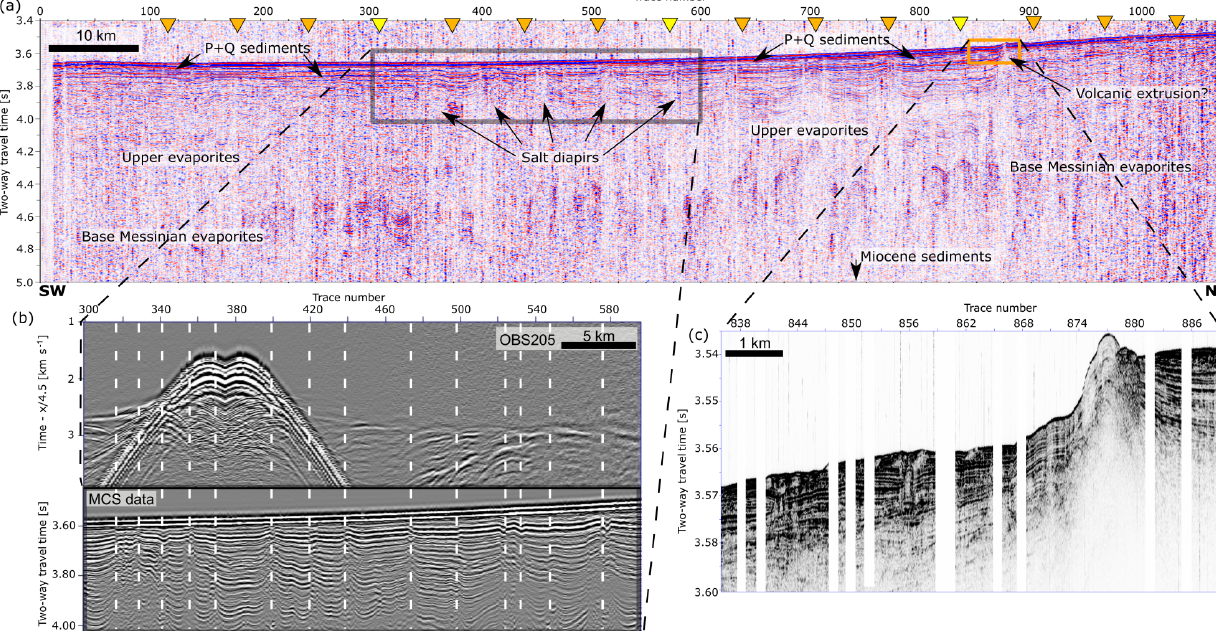
Figure 3. (a) Multi-channel seismic data (MCS data) simultaneously shot with the refraction seismic line. The orange and yellow triangles mark the OBS and OBH positions along the profile, respectively. (b) Upper panel shows OBS205 from shot point 300 to shot point 600 with a reduction velocity of 4.5kms − 1 . The lower panel is a zoomed-in view of the MCS section (black box in a ). The white lines show that the undulations in the sedimentary phases fit well with faults and salt diapirs. (c) Parasound sediment echo sounder data (orange box in a